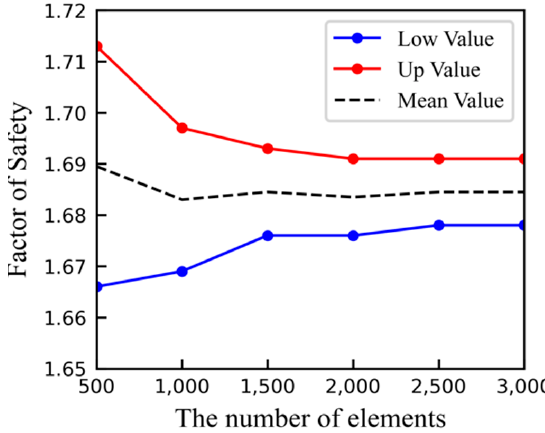
Figure 7. The choice of element number.